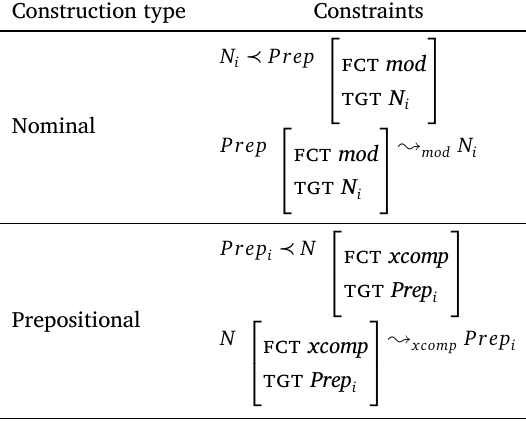
Co-indexation between constraints